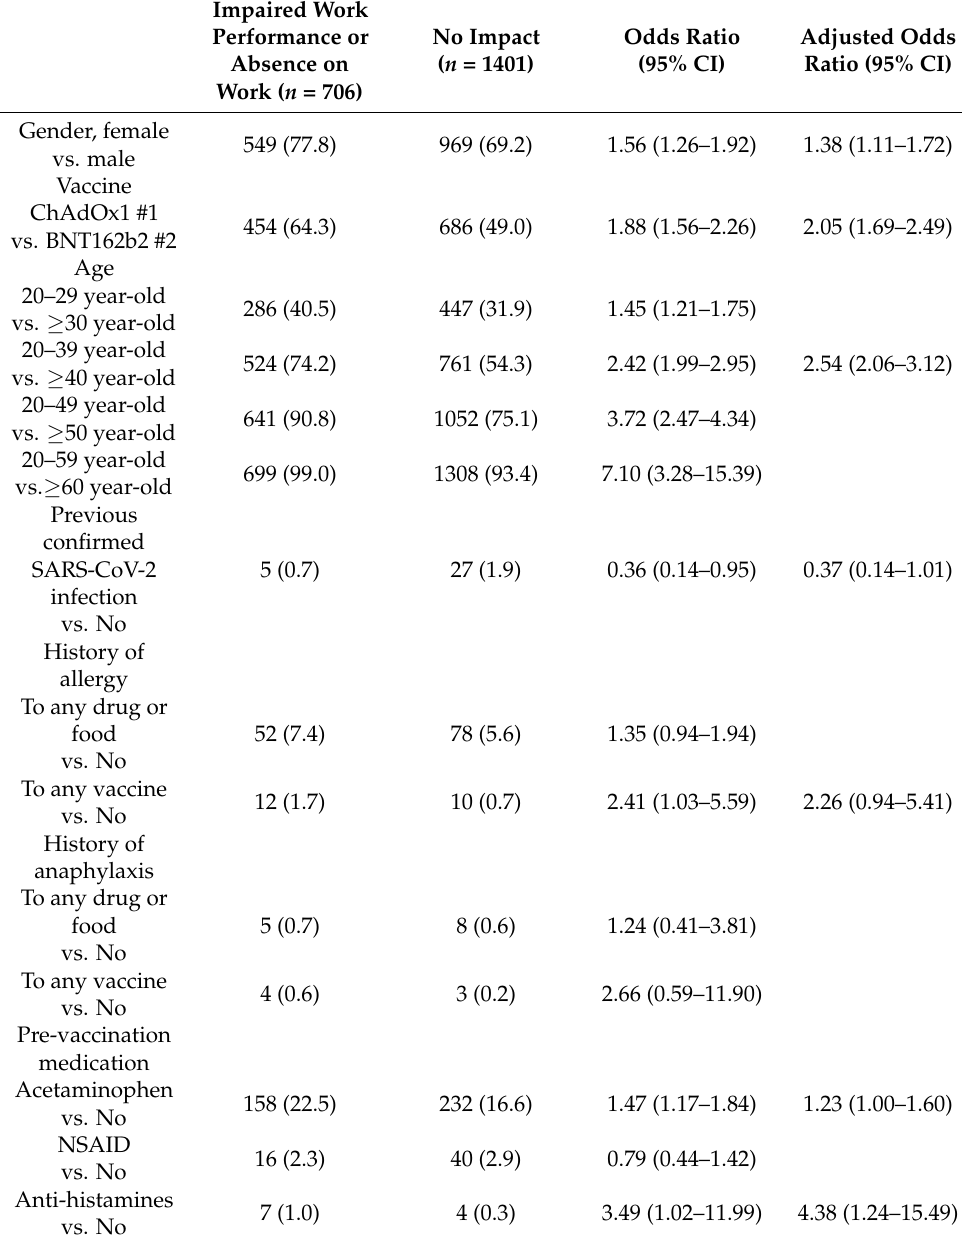
Table 3. Risk factors for impaired work performance or absence from work due to side effectsafter the second dose of BNT162b2 and the first dose of ChAdOx1